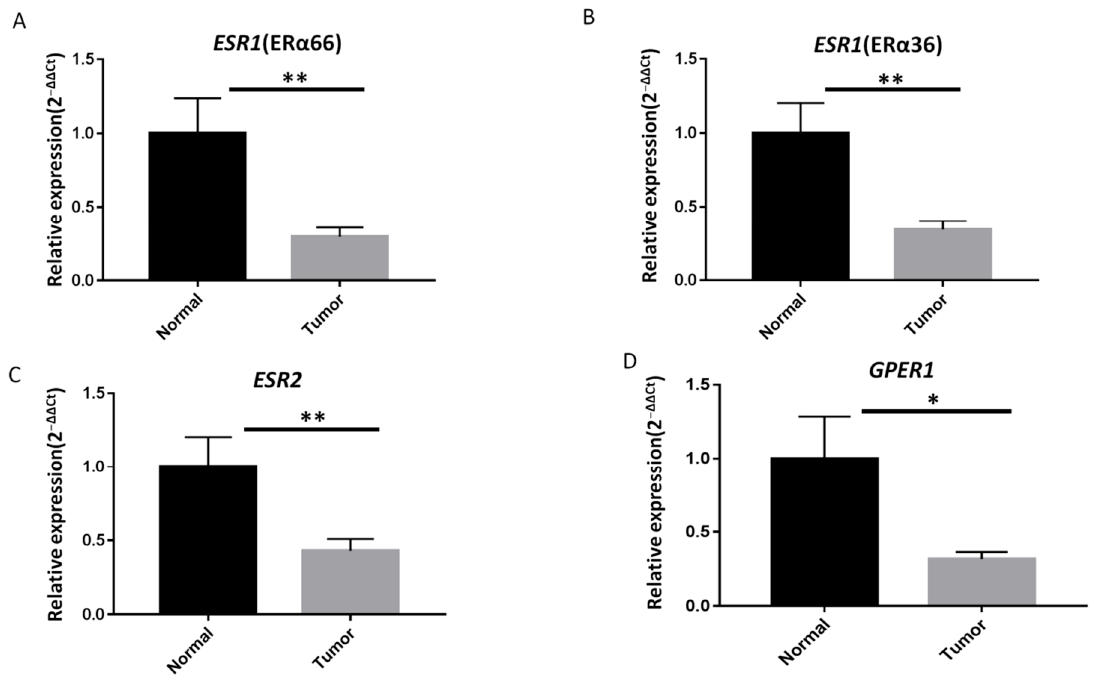
Figure 1. ER mRNA expression is lower in papillary thyroid carcinoma (PTC) specimens than in adjacent normal thyroid tissues. Quantitative reverse transcription polymerase chain reaction (RT-qPCR) analysis of ( A ) full-length estrogen receptor 1 (ER α 66), ( B ) 36 kDa version of ESR1 (ER α 36), ( C ) ER β , and ( D ) G-protein-coupled estrogen receptor 1 ( GPER1 ) mRNA expression levels in PTC specimens ( n = 103) and paired adjacent normal thyroid tissues. The fold change values indicate the relative change in the expression levels between samples and the internal control (18S rRNA), assuming that the expression level of 18S rRNA in each sample was set to 1. Relative mRNA expression levels in PTC specimens were normalized to adjacent normal tissues (T/N fold change). The mRNA expression levels of ER α 66, ER α 36, ER β , and GPER1 were significantly lower in tumor tissues than in matched adjacent normal tissues. Fold change in mRNA expression levels in tumor samples was calculated relative to that in paired normal thyroid tissue; ** p < 0.005, * p < 0.05.